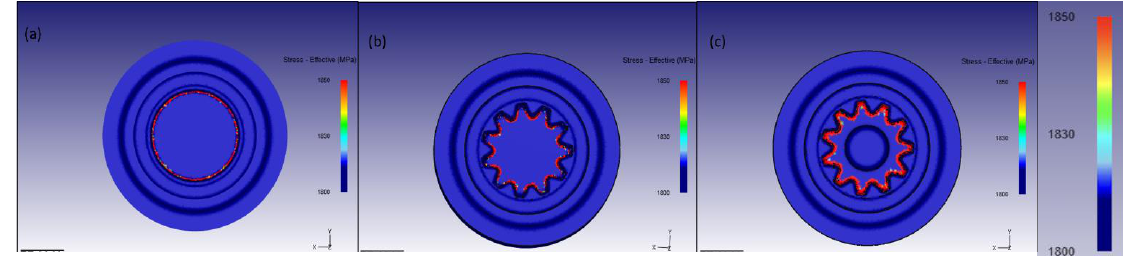
Figure 20. Deformed grid pattern flow line in the forged pinion head from top view: ( a ) Actual forged head, ( b ) Forged head with teeth, ( c ) Forged head with teeth and punched hole.